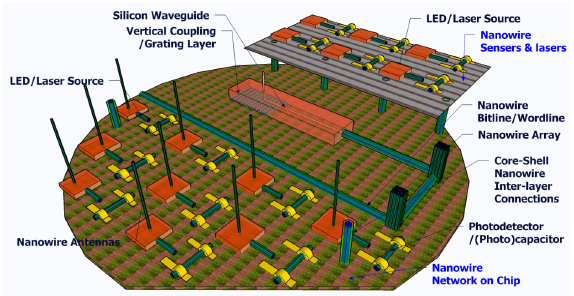
Figure 9: Schematic depiction of an optoelectronic nanosystem may include key components such as NW LED/laser source, photodetec- tor/photocapacitor, NW antennas, and NW-enabled network-on-chip integrated on